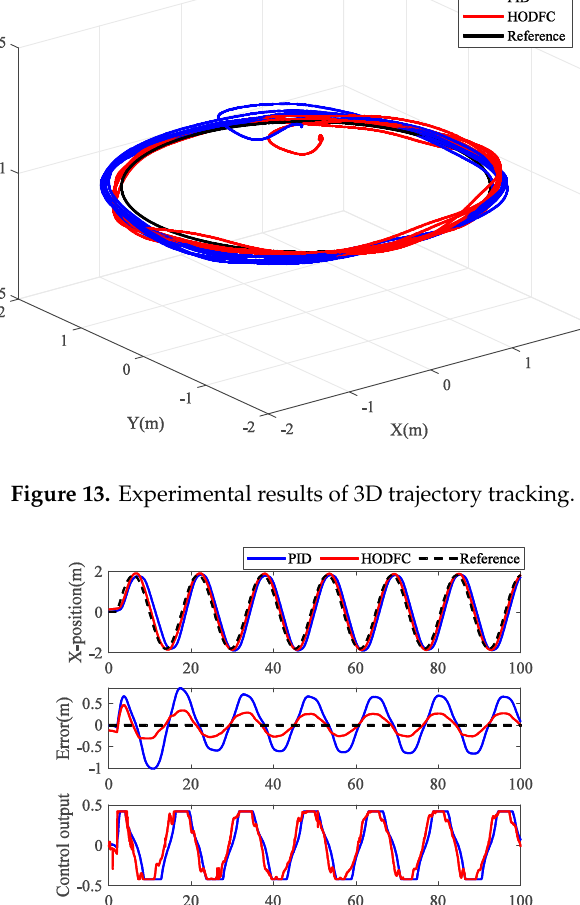
Figure 14. Experimental results of space spatial trajectory tracking in the x position.